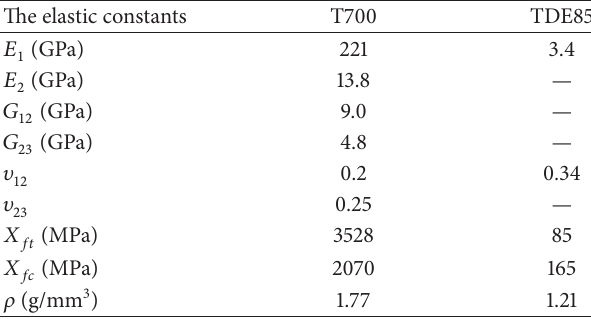
Table 1: Mechanical properties of T700 and TDE85.